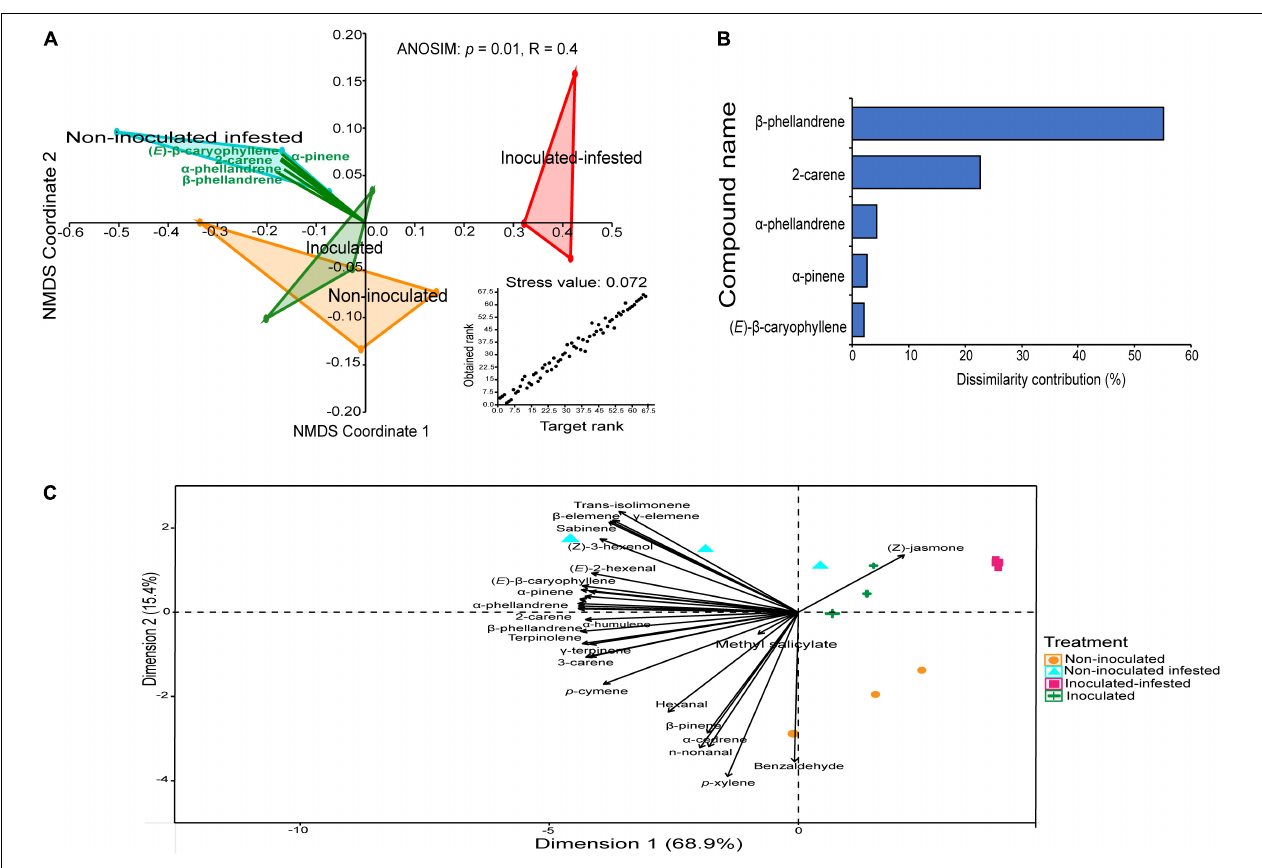
FIGURE 4 | Variations in volatile organic compounds across the four treatments. (A) Non-metric multidimensional scaling analysis (NMDS) of the volatile pattern of non-inoculated, inoculated, non-inoculated infested, and inoculated infested tomato plants showing the variation in volatiles. (B) Similarity percentage analysis and the percent contribution of the predominant compounds for the dissimilarity between the four treatments. (C) Principal component analysis (PCA) of the volatile profiles produced from non-inoculated, inoculated, non-inoculated infested, and inoculated infested tomato